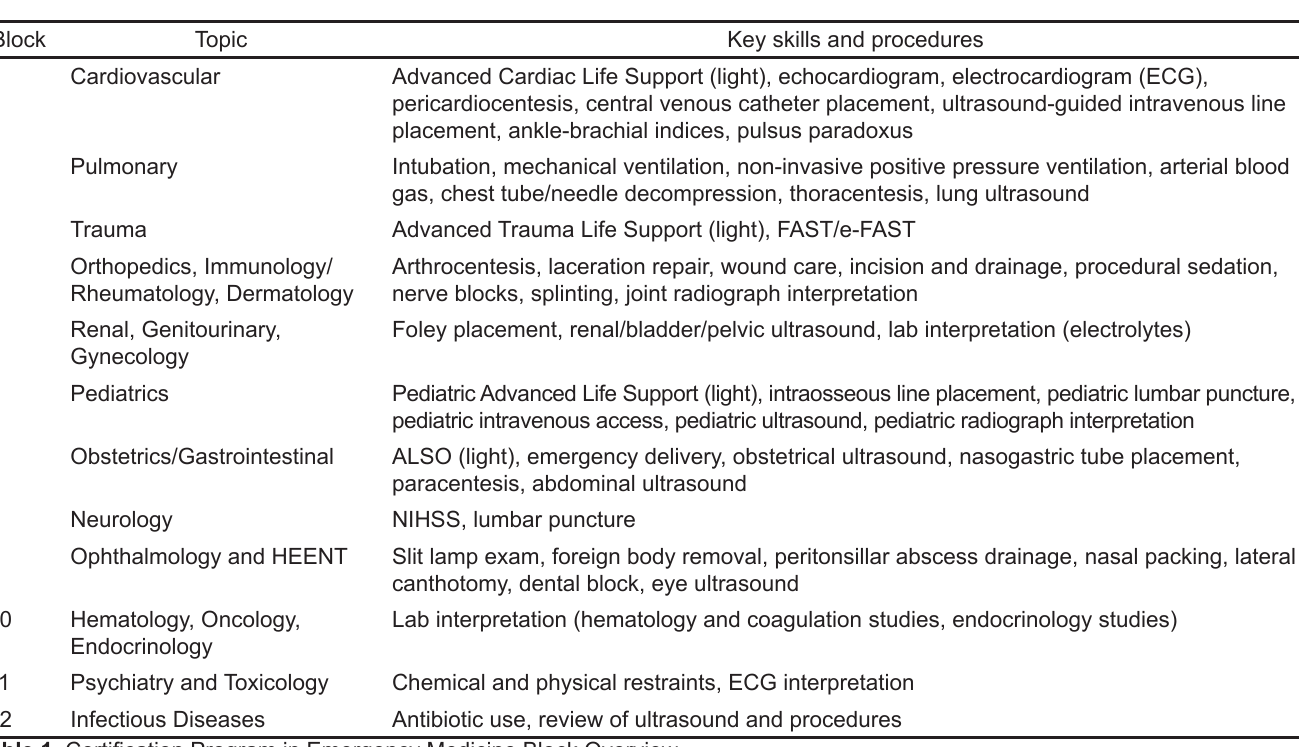
Table 1. Certification Program in Emergency Medicine Block Overview. ECG , electrocardiogram; FAST , focused assessment with sonography in trauma; e-FAST , extended focused assessment with sonography in trauma; ALSO , Advanced Life Support in Obstetrics; NIHSS , National Institutes of Health Stroke Scale; HEENT , head, eyes, ears, nose, and